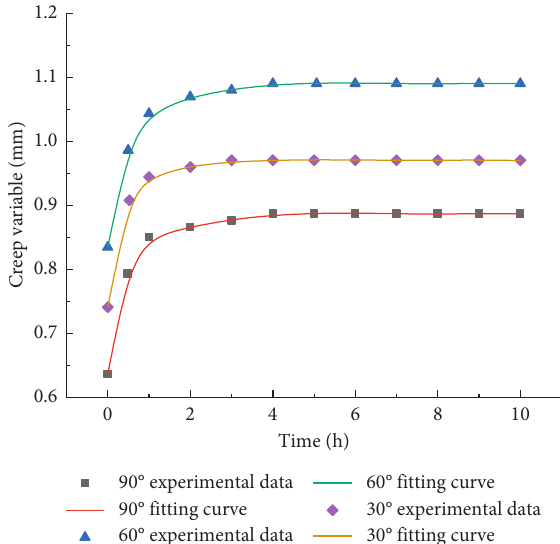
Figure 8: Comparison of fitting value of the creep model with experimental values.